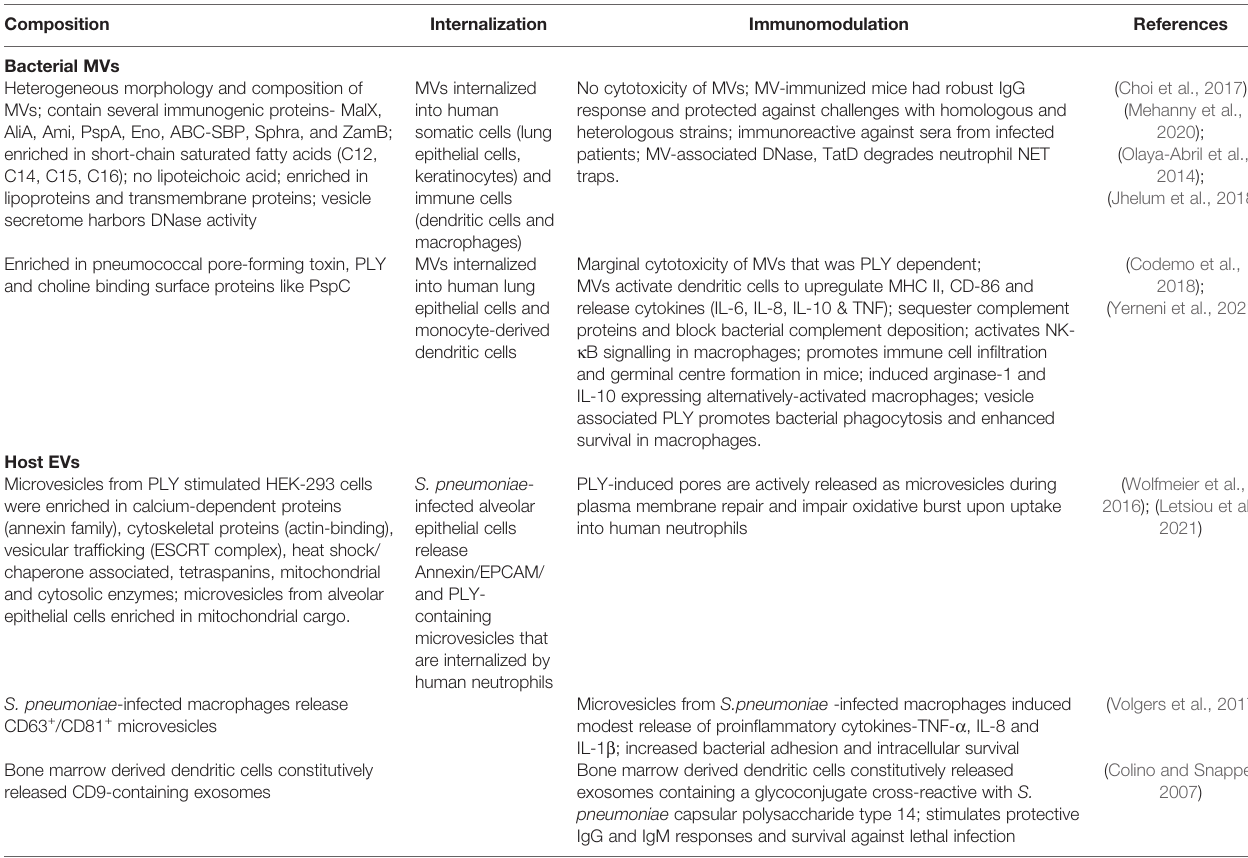
TABLE 1 | Characteristics and functions of bacterial and host vesicles in pneumococcal infections.